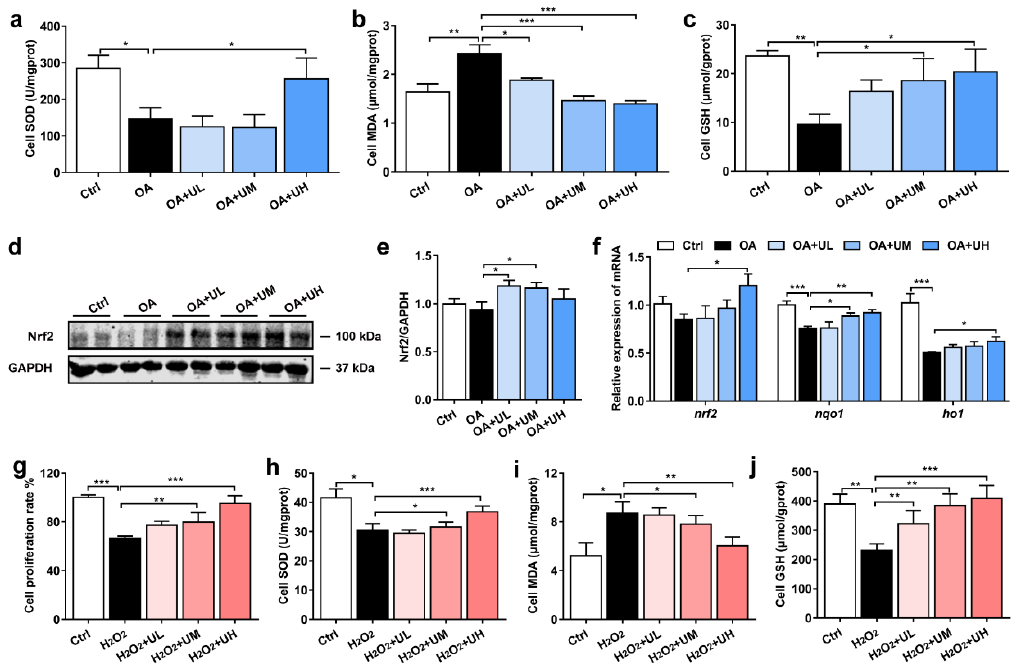
Figure 5. Uridine inhibited oxidative stress in the primary hepatocytes of Nile tilapia. ( a ) The activity of SOD in the primary hepatocytes ( n = 6). ( b ) The contents of MDA in the primary hepatocytes ( n = 6). ( c ) The contents of GSH in the primary hepatocytes ( n = 6). ( d ) The protein expression of Nrf2 in the hepatocytes ( n = 4). ( e ) Quantitation of Nrf2 levels normalized to GAPDH levels from blots shown in ( d ) ( n = 4). ( f ) The gene expression of Nrf2 signaling pathway in the hepatocytes ( n = 6). ( g ) The cells proliferation analyzed by CCK-8 in hydrogen peroxide (H 2 O 2 )-induced cell model ( n = 10). ( h ) The activity of SOD in the primary hepatocytes ( n = 6). ( i ) The contents of MDA in the primary hepatocytes ( n = 6). ( j ) The contents of GSH in the primary hepatocytes ( n = 6). Statistics were analyzed by one-way ANOVA with Tukey’s adjustment and presented as mean ± SEM (*, p < 0.05; **, p < 0.01; ***, p <